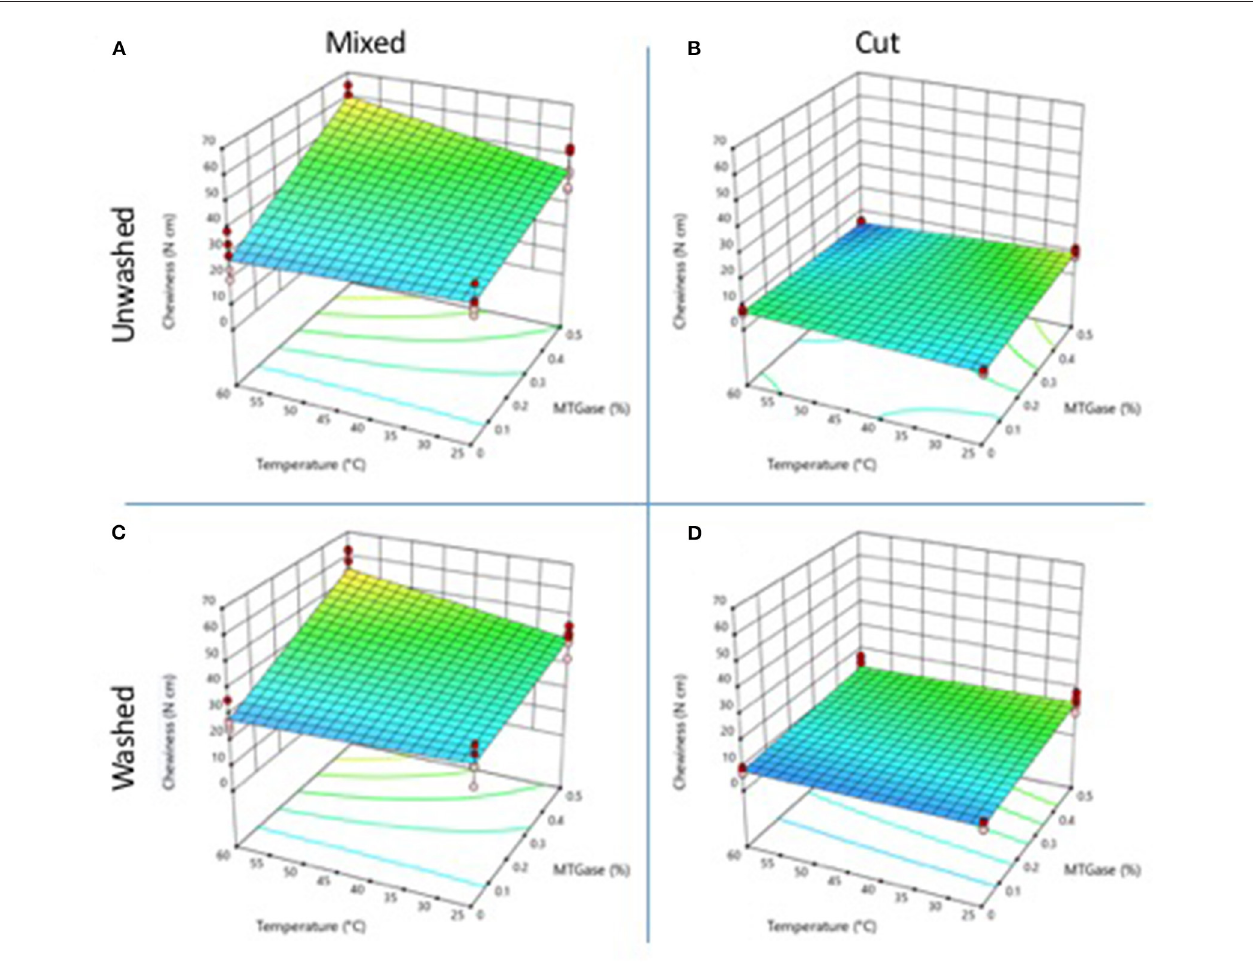
FIGURE 4 | Changes in gel chewiness properties as a function of the type and temperature mixing method, washing of the cooked meat, and adding of microbial MTGase. (A) Mixed-unwashed samples, (B) Cut-unwashed samples, (C) Mixed-washed samples, and (D) Cut-washed